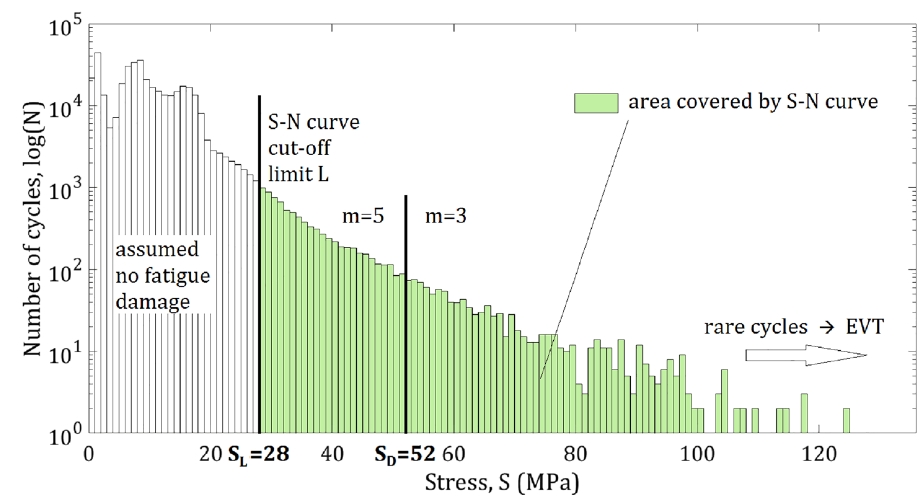
Fig. 8 Stress cycles